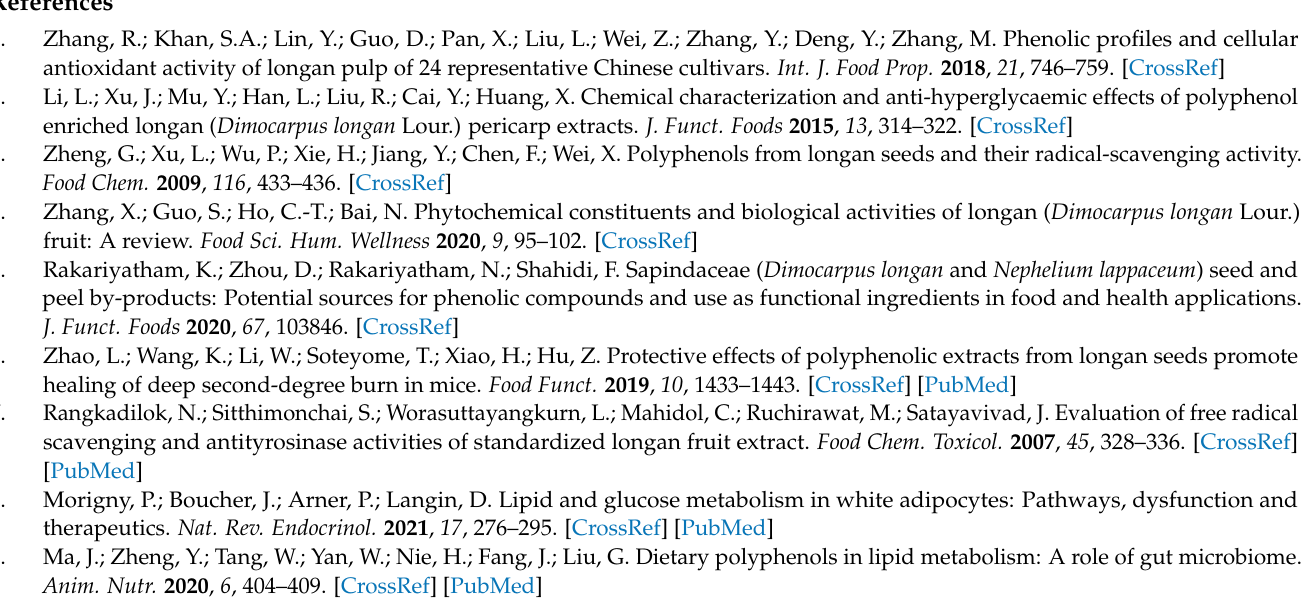
Table S1: The densitometry readings for all the western blot